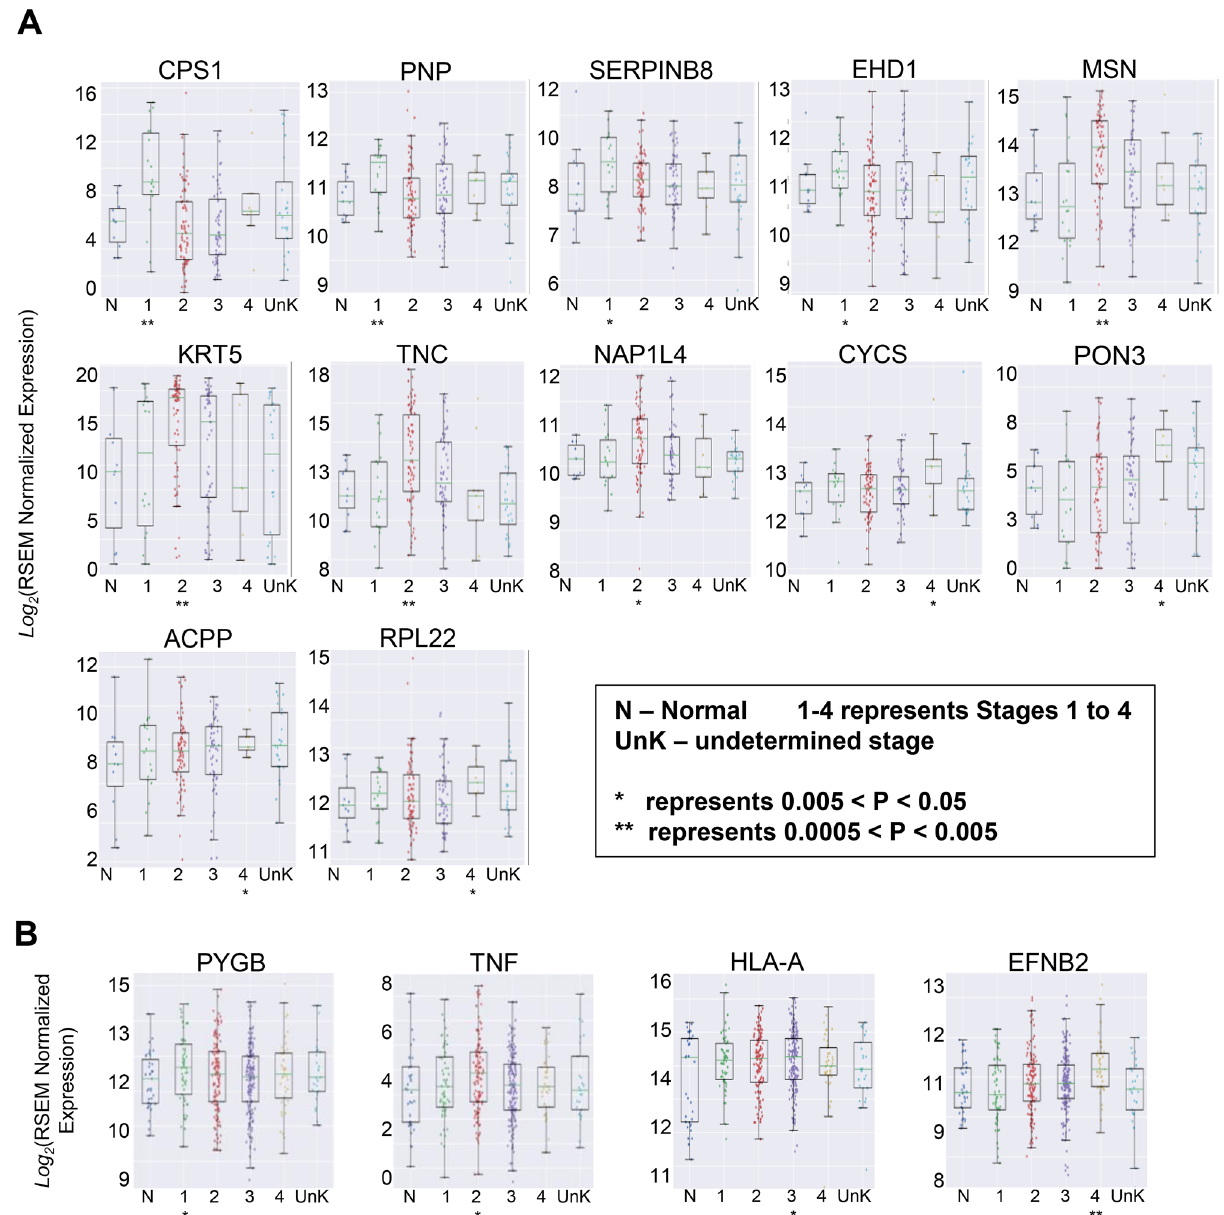
Figure 2. ( A ) Stage-based analysis of esophageal cancer showed a differential expression of various genes based on the stage of the disease. ( B ) Stage-based analysis showed a differential expression of various genes based on the stage of the disease in patients with stomach